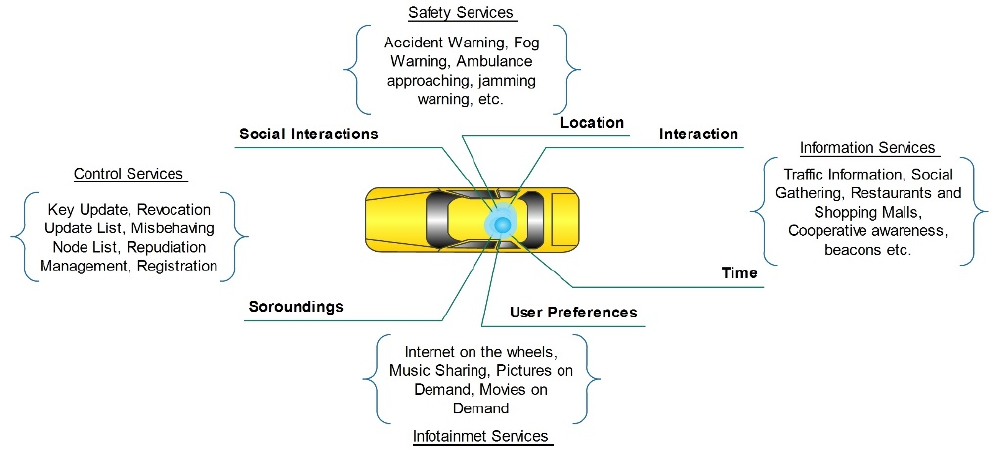
Figure 25. Taxonomy of safety services in SDN-based VANETs.